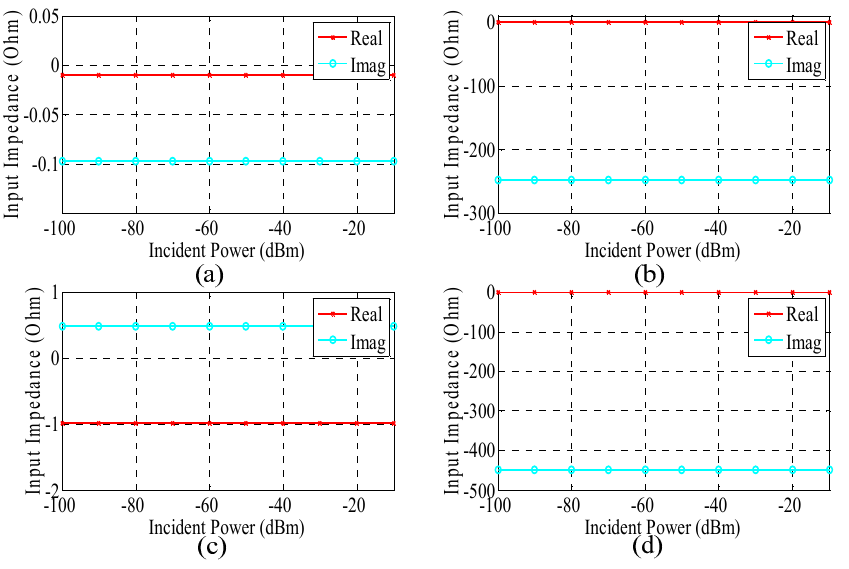
Figure 6. Radio frequency (RF) input impedance versus P inc at f = 2.45 GHz for some commercially Schottky diodes.